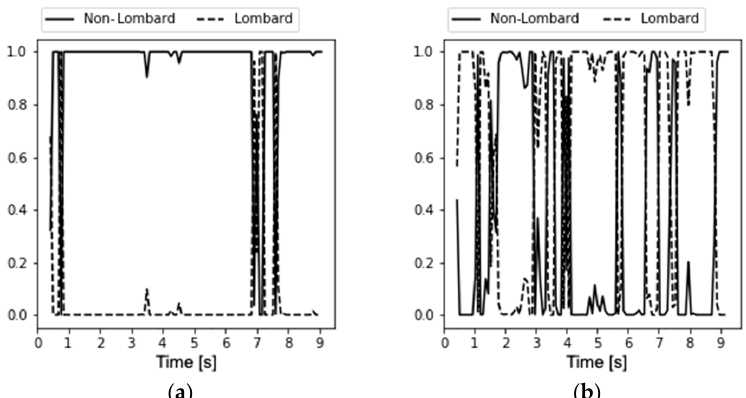
Figure 4. Sample detection results for ( a ) neutral speech recording and ( b ) Lombard speech recording.